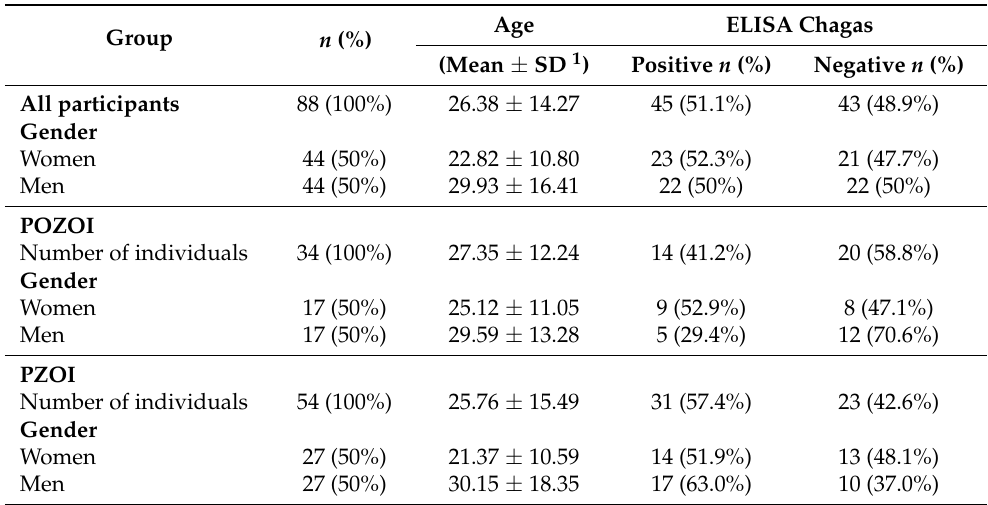
Table 5. Main demographic characteristics and Chagas disease seroprevalence among the Hitnü indigenous population ( n =